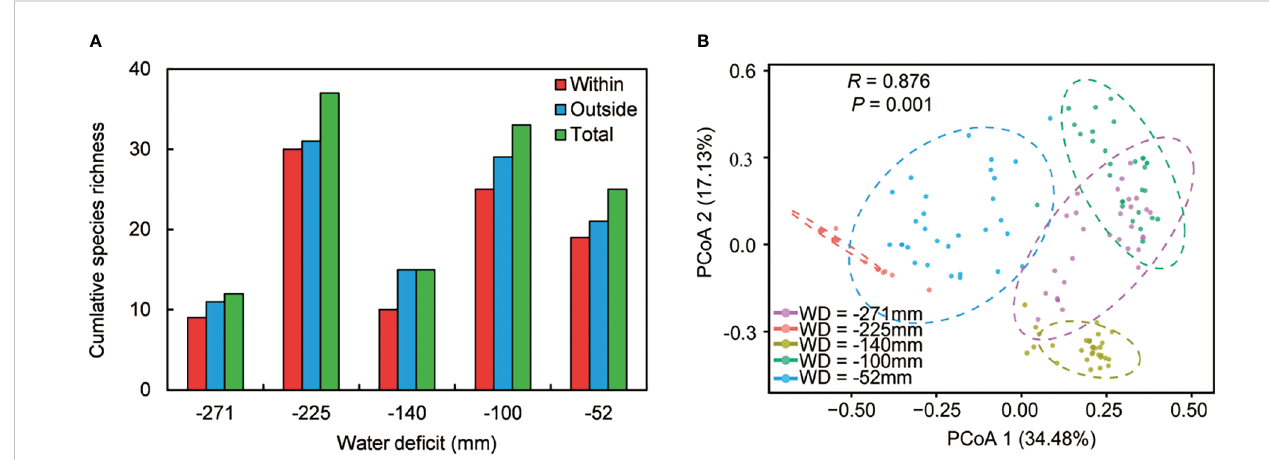
FIGURE 2 (A) Species richness under Caragana versicolor (within), in open areas (outside) and at the community level (total) along the water de fi cit gradient in drylands of Tibetan Plateau. (B) Ordination diagram showing Principal Coordinates Analysis (PCoA) performed for species composition in open